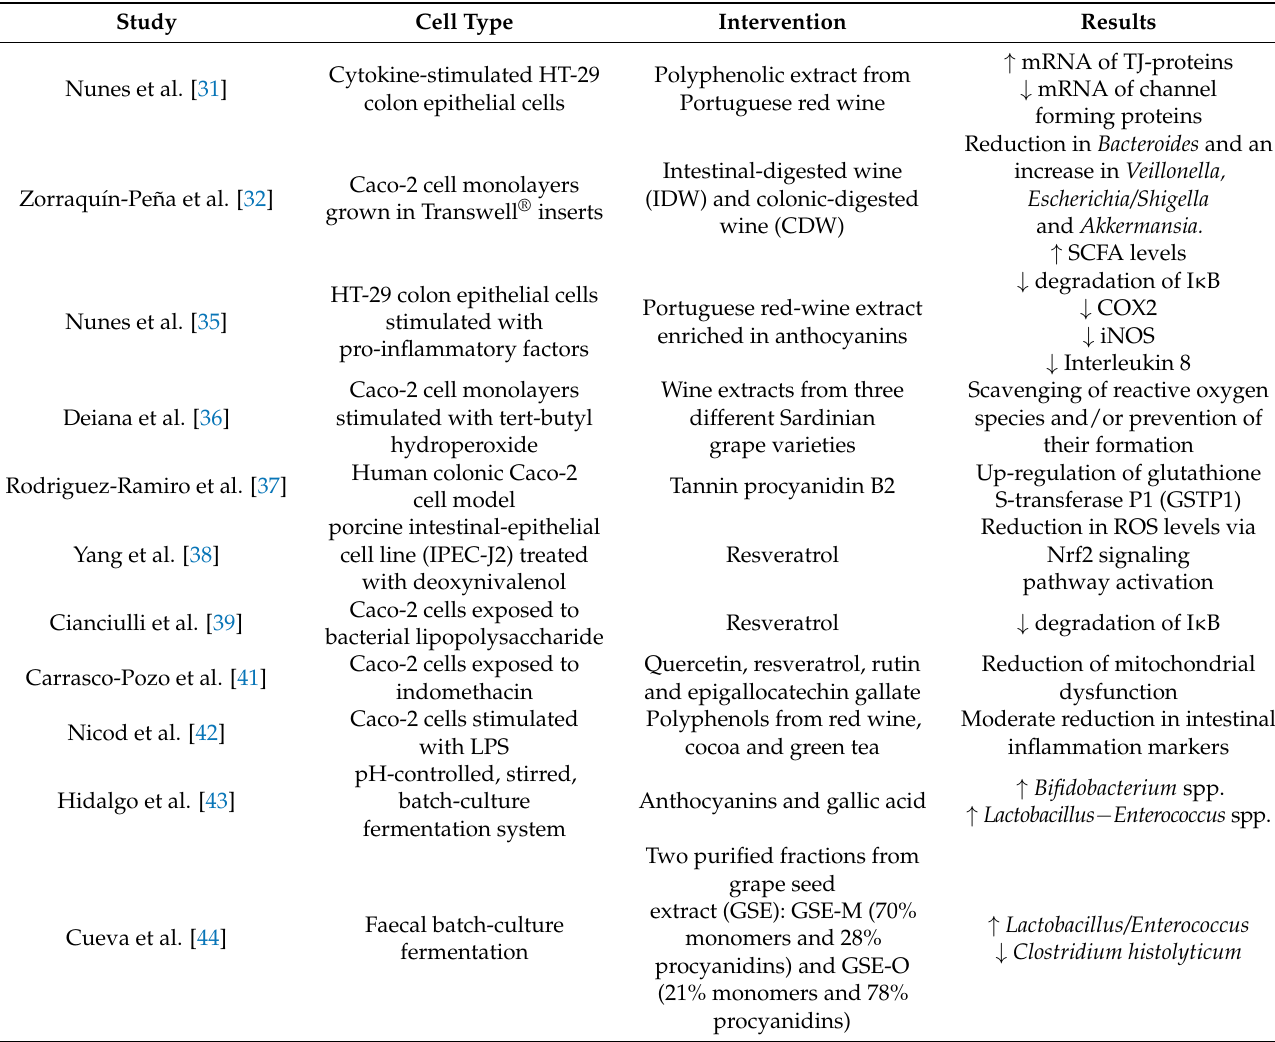
Table 1. In vitro studies on wine polyphenols and intestinal